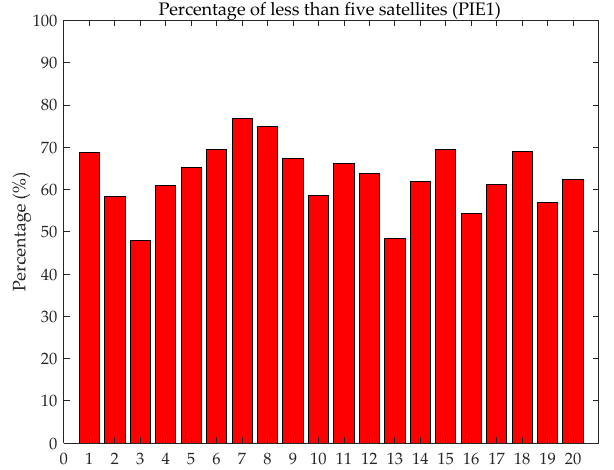
Figure 14. Fewer than five satellites participating in static PPP at PIE1 station accounted for the total epoch (20 days) .